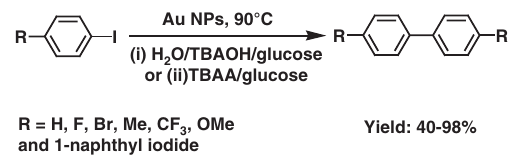
/CeO catalyst. (A) 25 2